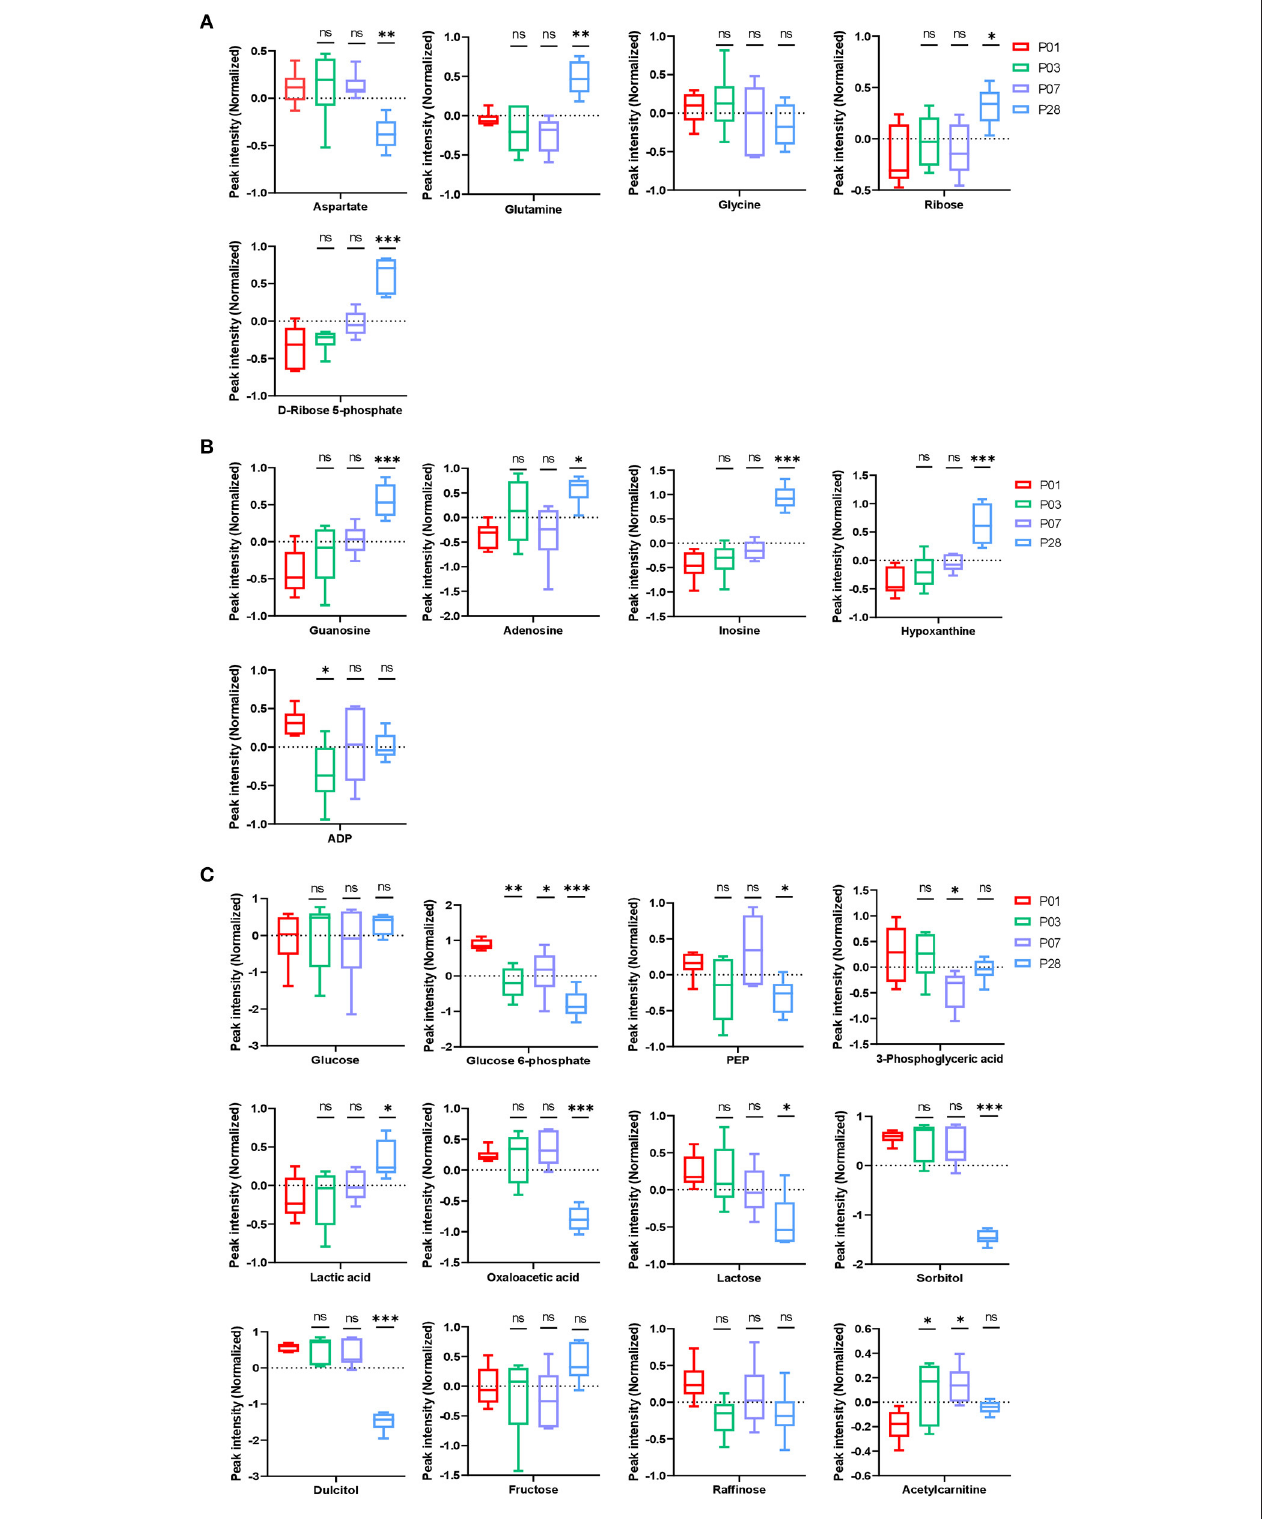
FIGURE 2 | Nucleotide and carbohydrate metabolism in neonatal pig hearts. (A,B) Metabolites in the pathway of nucleotide synthesis (A) and break down (B) in the four sets of heart samples (P1, P3, P7, and P28 hearts). (C) Metabolic profile of glucose, other sugars, and fatty acids. * p < 0.05, ** p < 0.01, *** p < 0.001, one-way ANOVA with Tukey’s Honestly Significant Difference Test. n = 6 hearts per